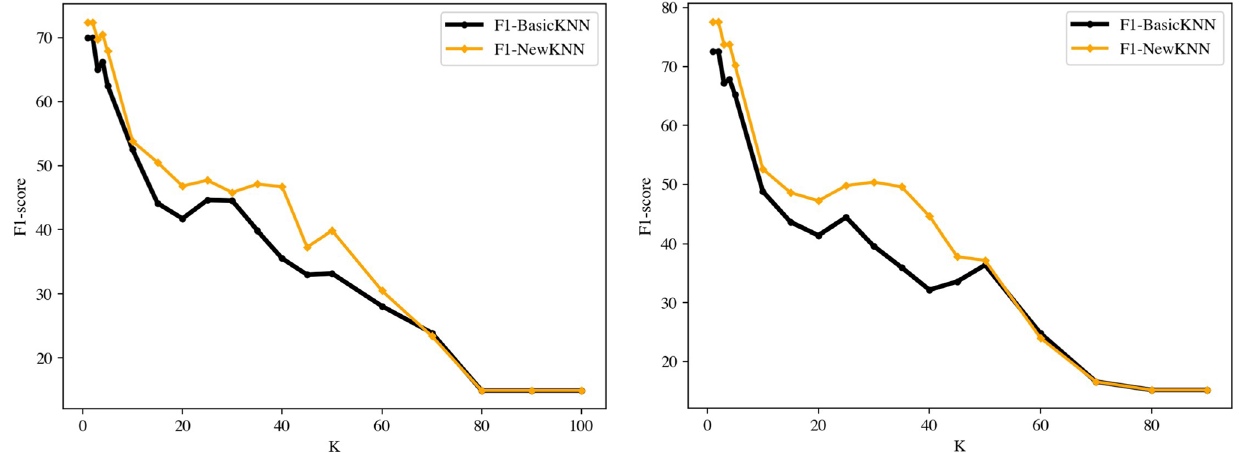
Fig. 2 F1-score evolution for KNN using Euclidean distance with tenfold and fivefold cross-validation on Restaurant